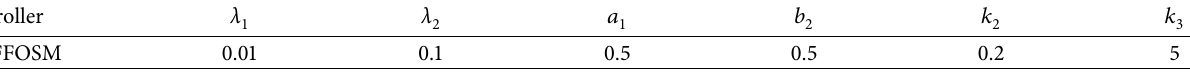
Table 1: The control performance comparisons under different control schemes.